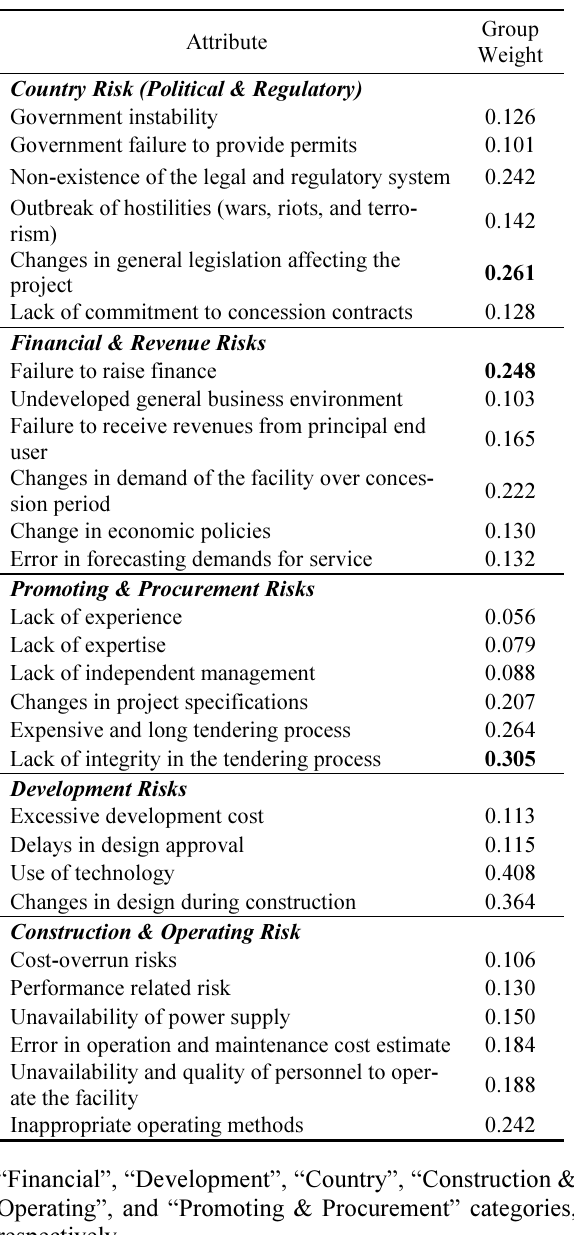
Table 4. Group weights for comparison of attributes within